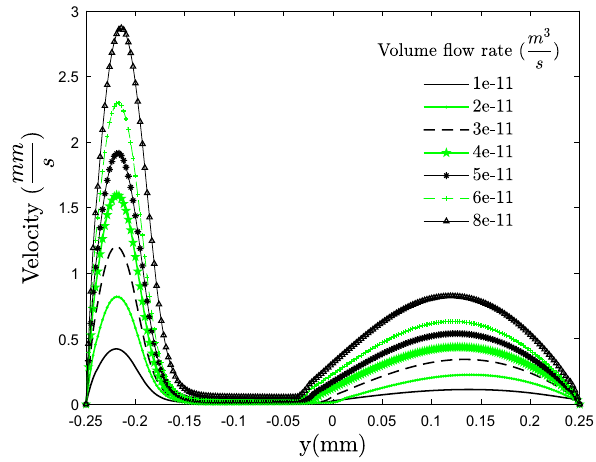
Fig. 8 Velocity profiles of different volume flow rates through the channel’s height after 1 min